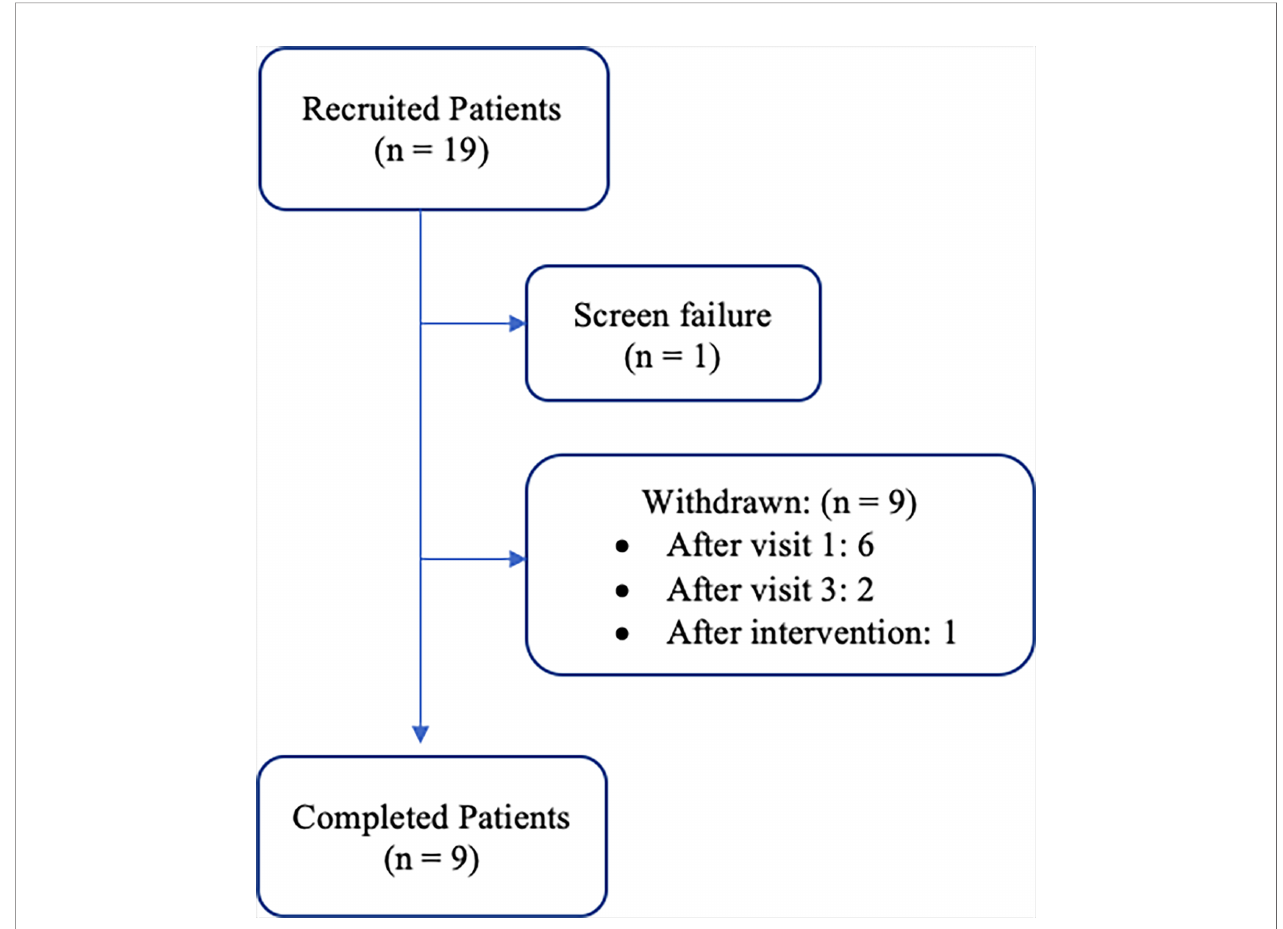
FIGURE 1 | Patient cohort fl ow diagram: recruitment and retention of participants throughout the duration of the study